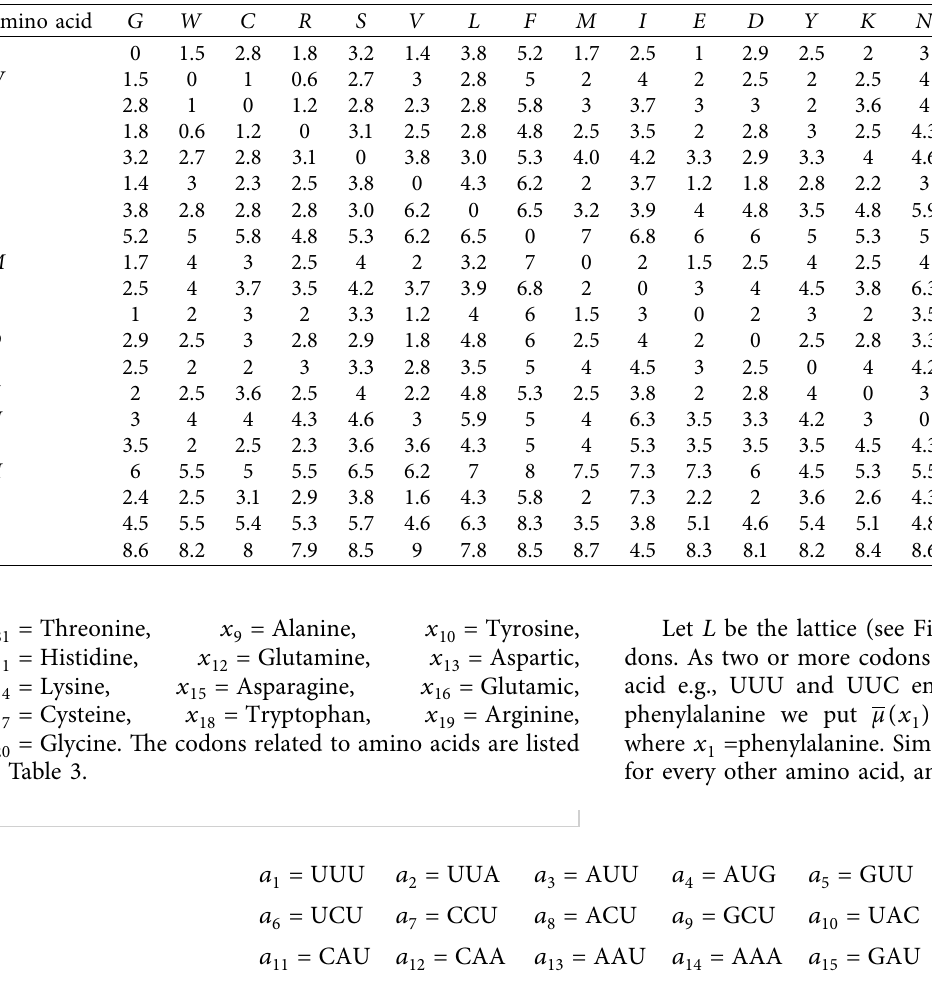
Table 5: Hamming distance between pairs of Amino